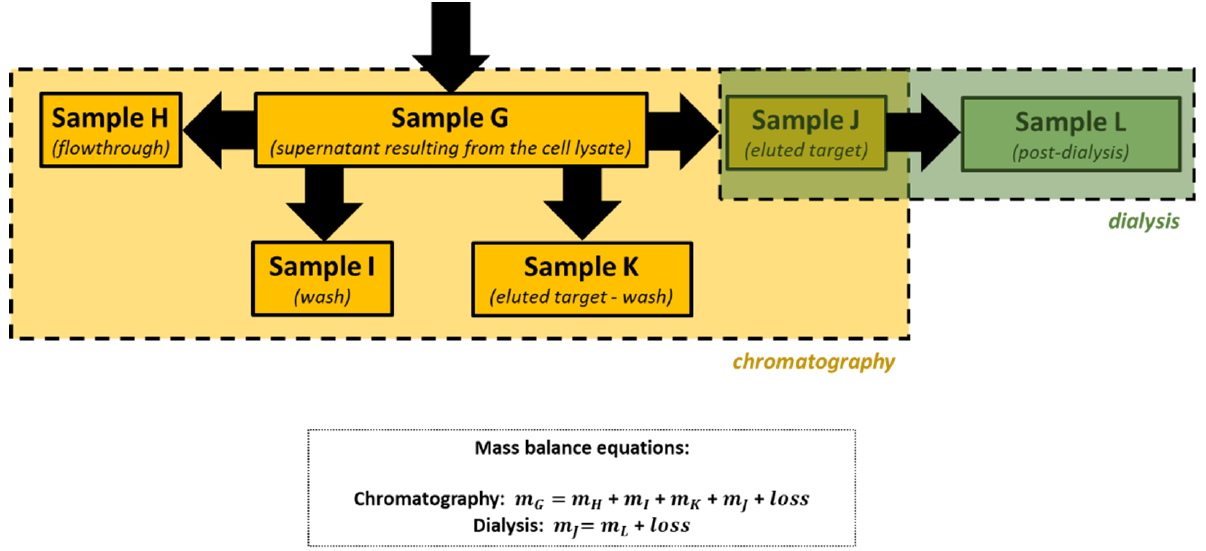
Figure 5. Process flow diagram and mass balance equations associated with eGFP purification.